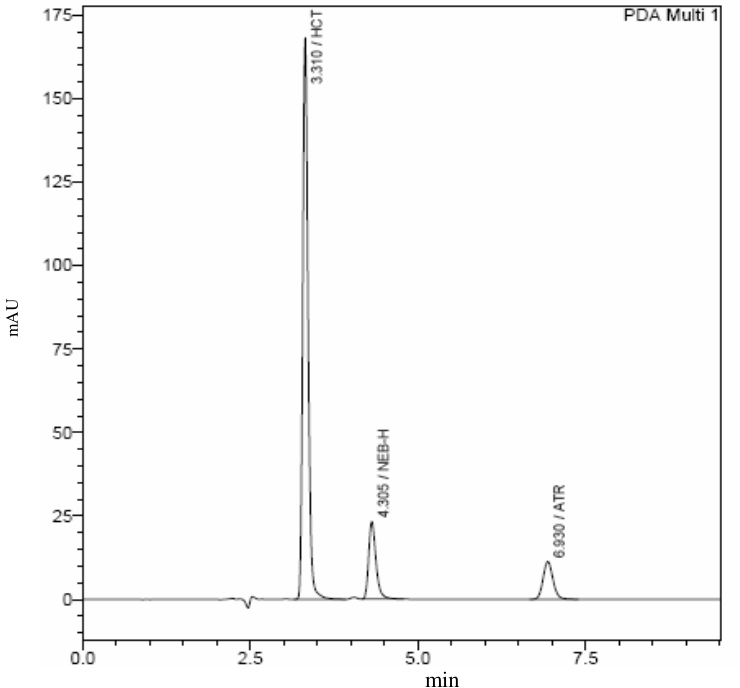
Figure 2. RP-HPLC Chromatogram of tablet sample with internal standard (NEB-H, HCT&